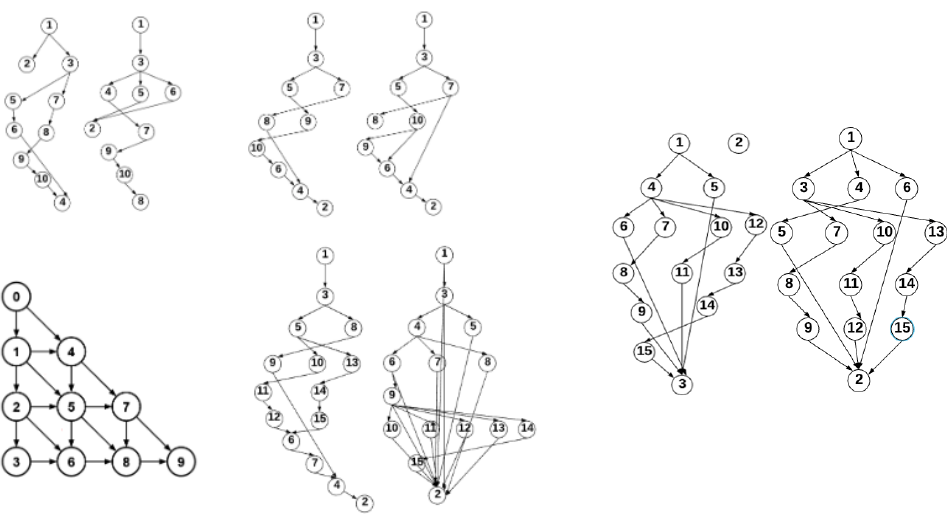
Figure 5. Application communication